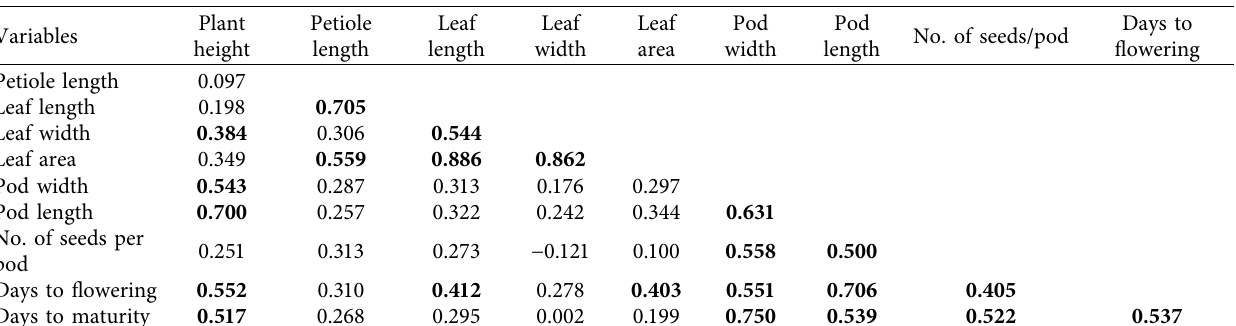
Table 4: Pearson correlation between selected quantitative